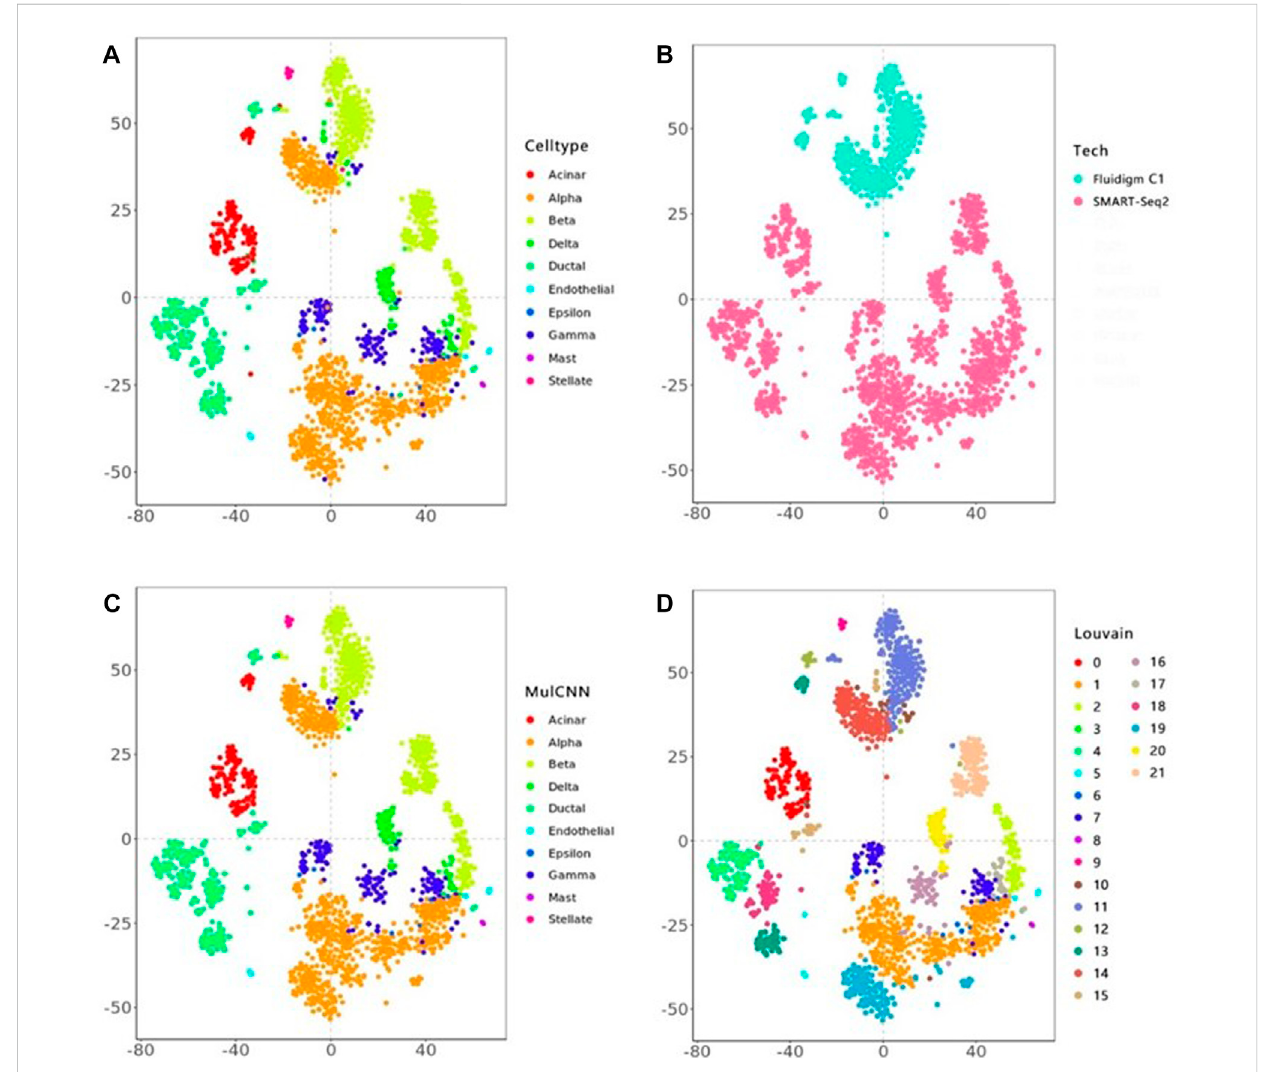
FIGURE 4 t-SNE visual analysis of the Lawlor + Segerstolpe dataset. (A) Distribution of real cell types; (B) Distribution of different batches of cells; (C) Distribution of cell types predicted by MulCNN; (D) Distribution of cell types predicted by Louvain.